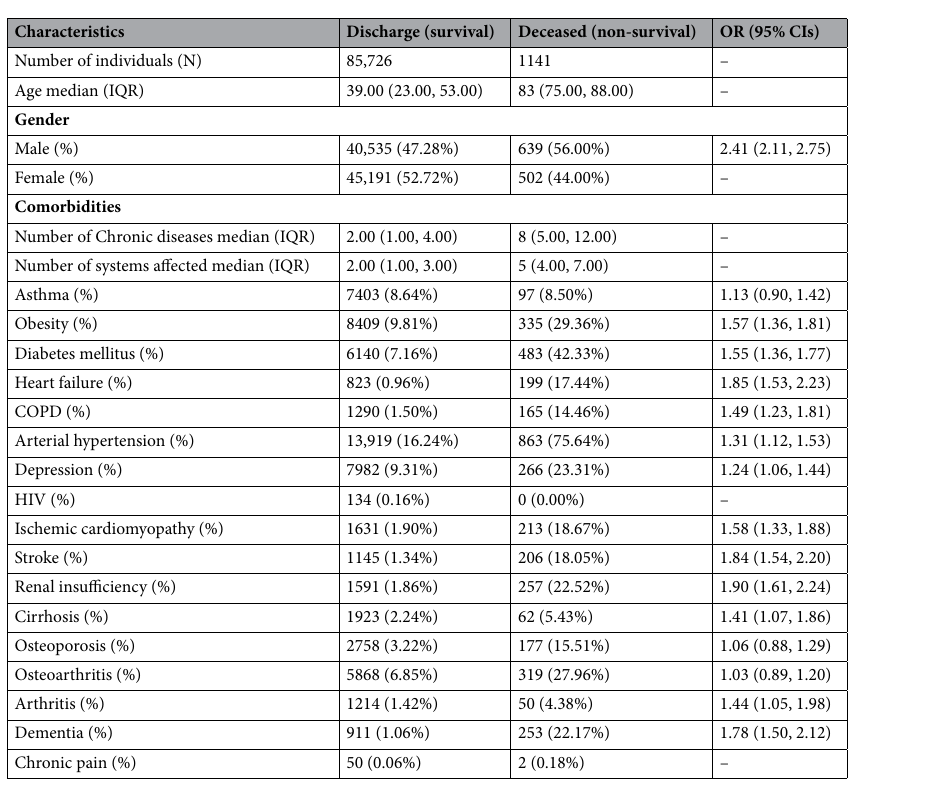
Table 2. Demographic characteristics and comorbidities of discharge and deceased COVID-19 patients. Deceased (report only when the patient dies). Continuous data are reported as median with interquartile range (Q3–Q1), and categorical data are expressed as percentages (%). We also used odds ratio (OR) and 95% CIs. COPD is a chronic obstructive pulmonary disease and HIV is Acquired Immune Deficiency